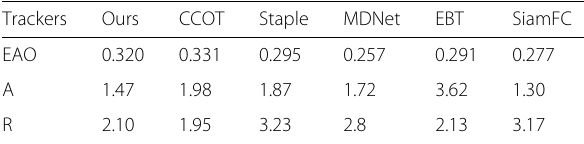
Table 2 Tracking results on the VOT2016 dataset in terms of expected average overlap (EAO), accuracy rank (A), and robustness rank (R) Trackers Ours CCOT Staple MDNet